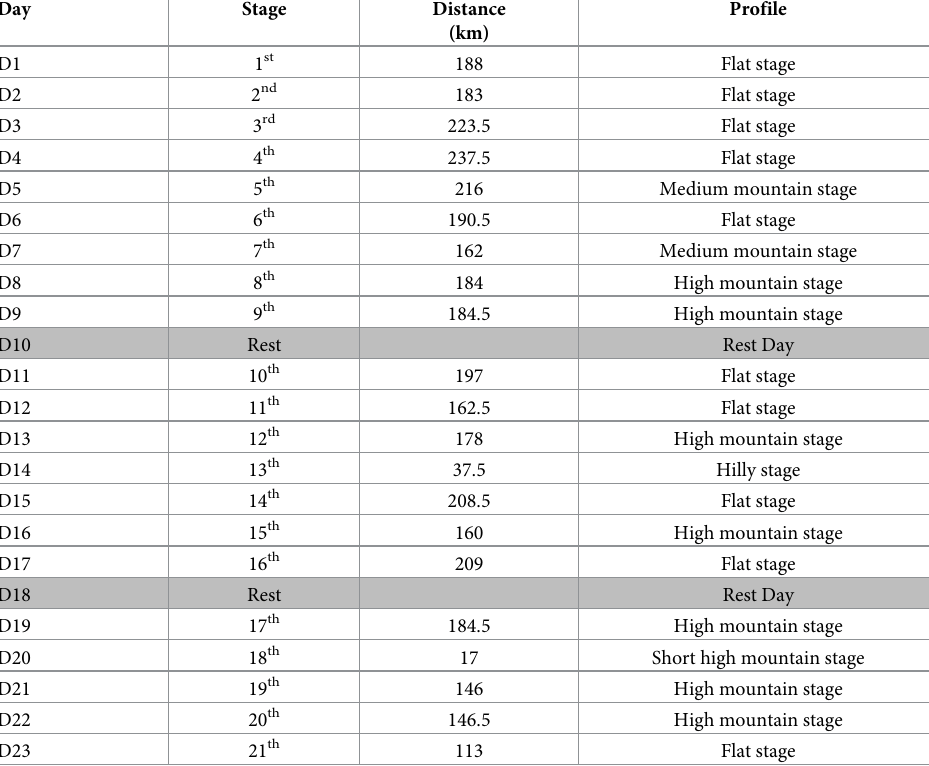
Table 1. Characteristics of the multi-stage